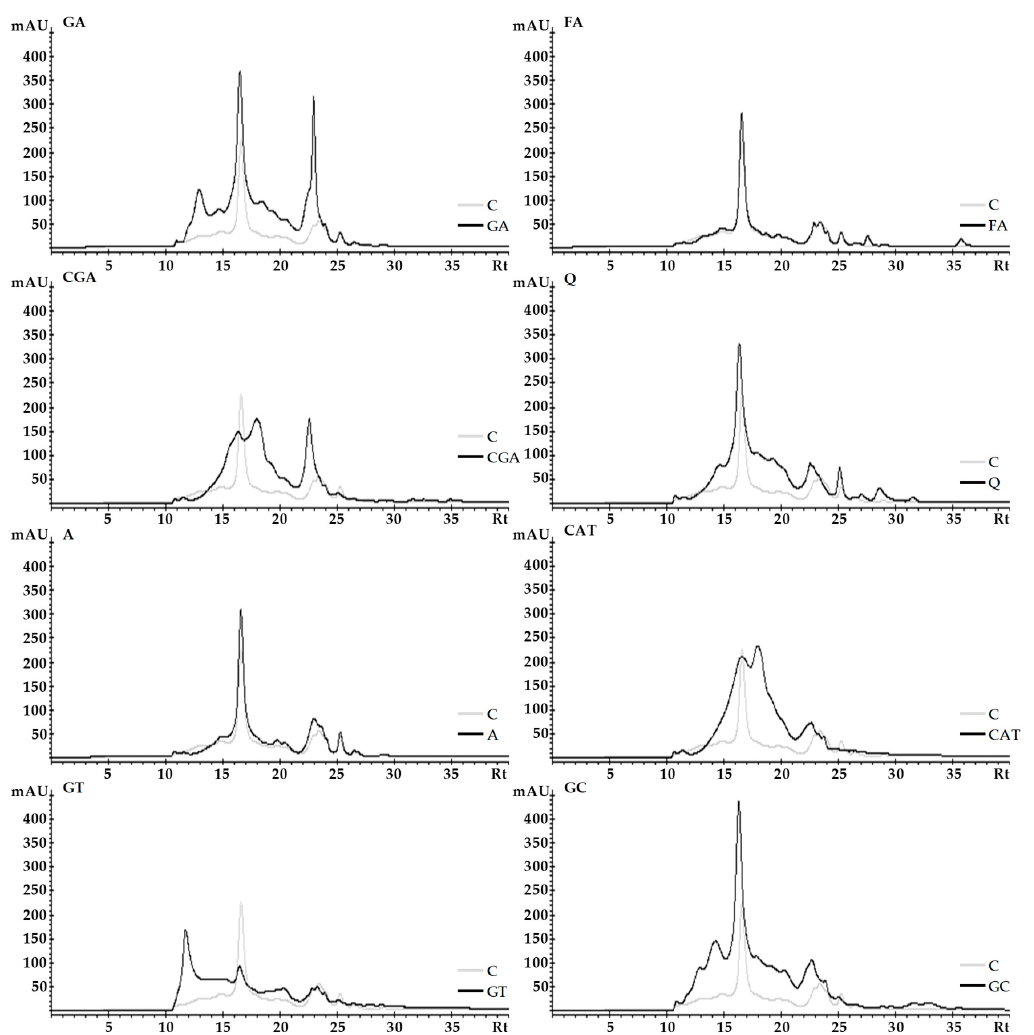
Figure 4. The effect of phenolic compounds on the SE-HPLC elution profiles of globulins. C–control sample, GA, FA, CGA, Q, A, CAT, GT, GC–protein samples after incubation with gallic acid, ferulic acid, chlorogenic acid, quercetin, apigenin, catechin, green tea, and green coffee extracts, respectively.